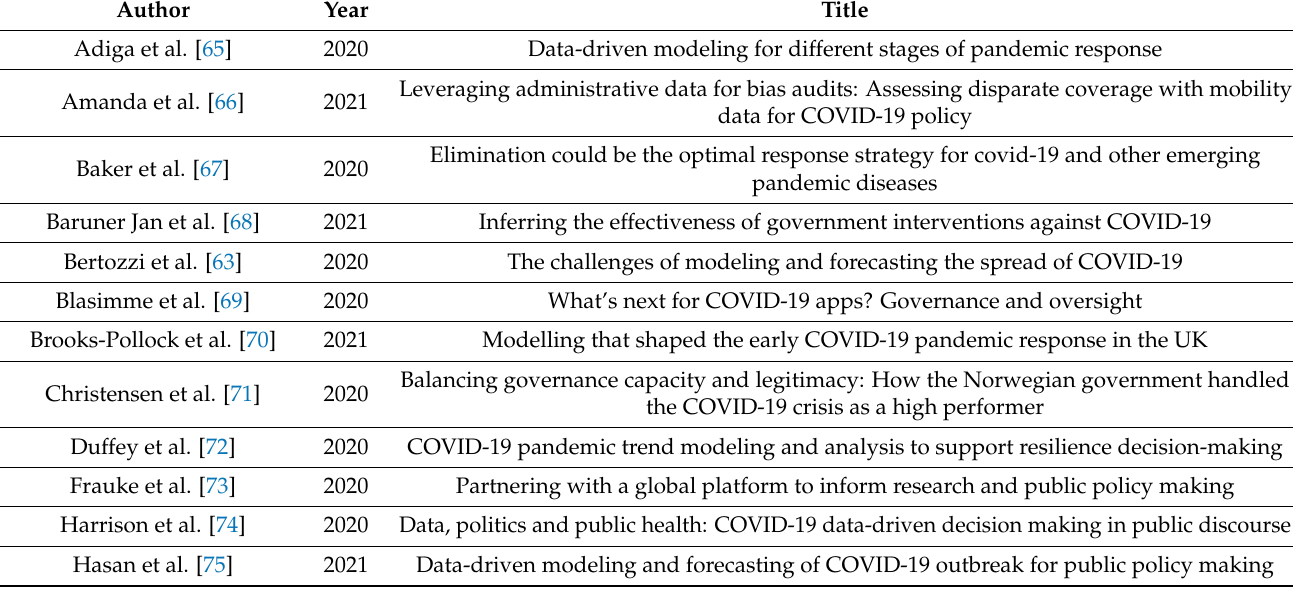
Table 2. List of articles included in the final